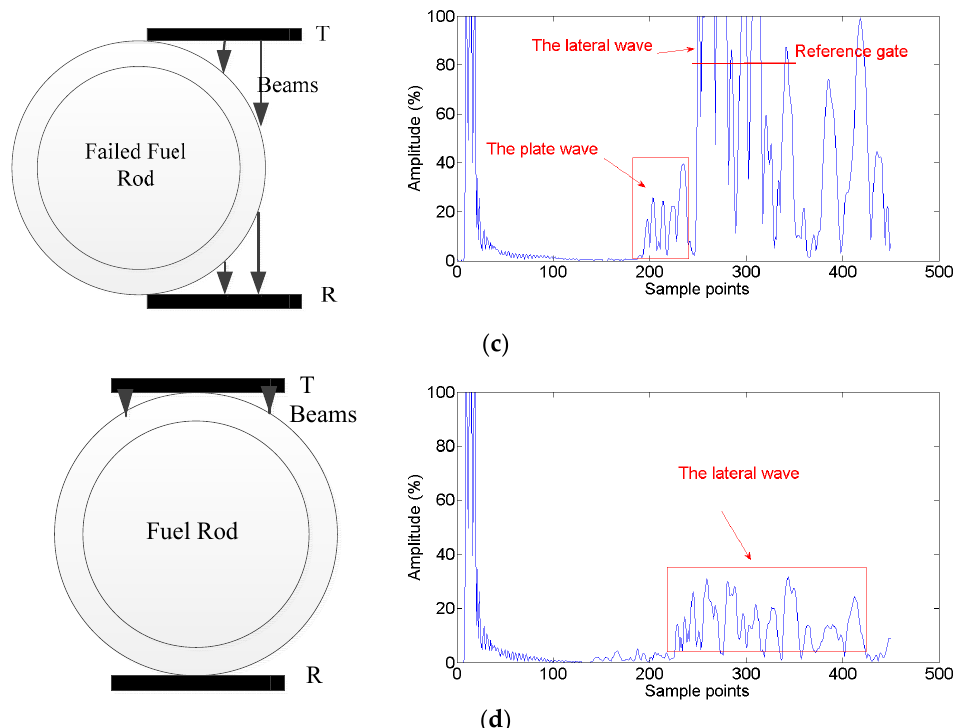
Figure 9. ( a ) The signal when the rod is out of ultrasound range; ( b ) the signal of normal fuel rod when part of the rod is in ultrasound range; ( c ) the signal of failed fuel rod when part of the rod is in ultrasound range;( d ) the signal when the rod is in the center of the T/R transducers. Figure 10 shows the B-scan image converted from the A-scan sequence. It can be clearly seen that the signal of the fuel rod is composed of left and right parts, respectively. The sliding window is shown on the B-scan image as red rectangles. The yellow ellipse shows the signal when the rod is at the center of the T/R transducers. From the color pal- ette, we can see that the redder the color, the higher the amplitude. Therefore, the pixel color in the red rectangle is able to demonstrate the average energy. The more red or or- ange color pixels, the higher the average energy. It is apparent that the average energy of the non-failed rod is higher than that of the failed rod. Meanwhile, the average energy in the yellow ellipse of the non-failed rod is lower than that of the failed rod. The size of the calibrated sliding window is 140 × 85 pixels. According to Equation (17), the plate wave energy of the failed fuel rod is 3.1913 × 10³ and 3.5308 × 10³. By comparison, the plate wave energy of the normal fuel rod is much higher, which is 4.1068 × 10³ and 4.4032 × 10³, re- spectively. The detailed results of all fuel rods are shown in Table 2. All of the failed fuel rods can be detected. The detection rate of the failed fuel rods can reach 100%. Compared with the previous work [3], the detection rate increased by 7%. The comparison is shown in Table 3. Figure 10. The B-scan image with sliding window. Table 2. The results of the proposed method.